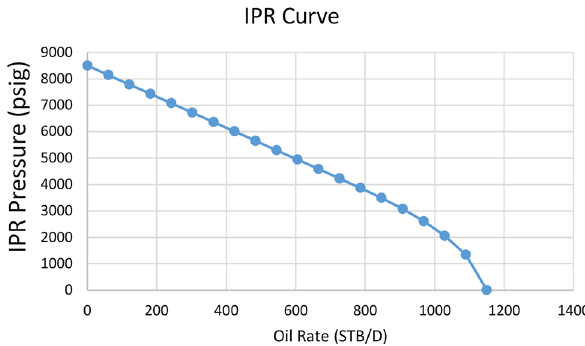
Fig. 3 The accelerating pace of productivity rate before acidizing (IPR curve)